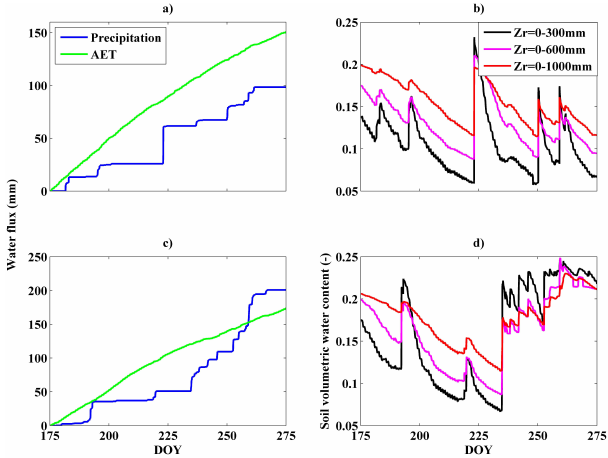
Fig. 1. Measured time series of precipitation (cumulative), evapo- transpiration (cumulative) and soil moisture during a dry summer (2003, a and b ) and a wet summer (2004, c and d ) at the mature stand